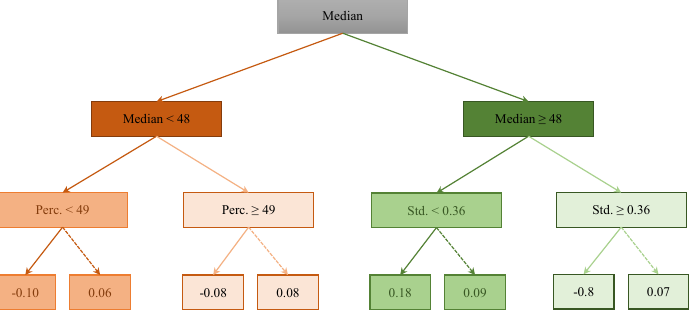
Figure 1. The architecture of gradient boosting machine. Rectangles in the figure show the split criteria while the end node is called